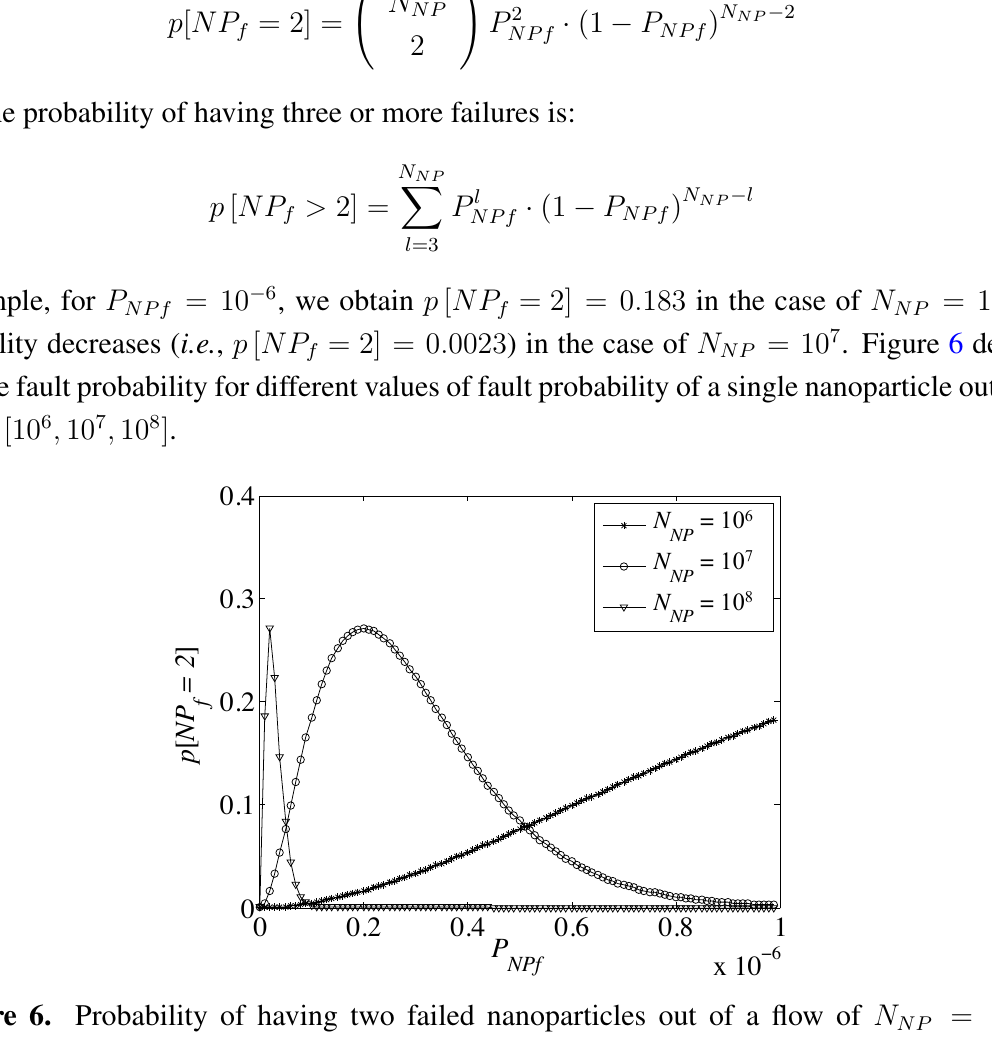
= 10 8 (upward-pointing NP